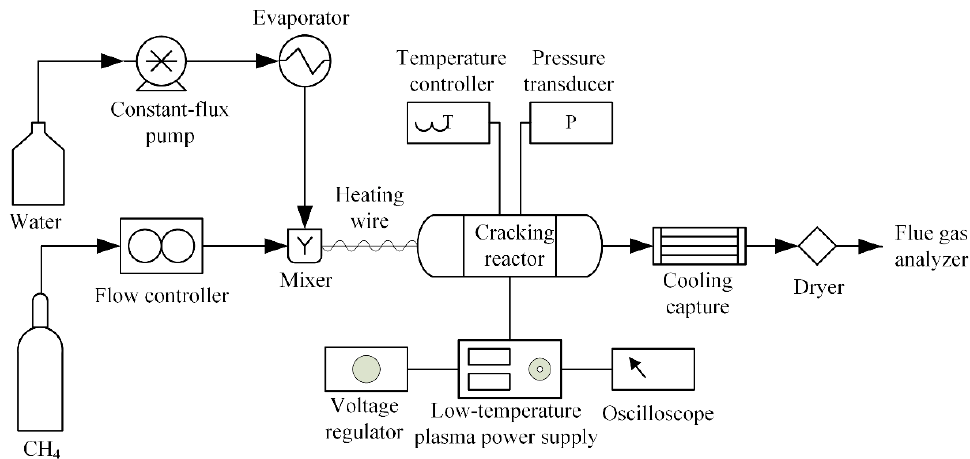
Figure 7. Arrangement diagram of a low-temperature plasma catalyzed CH 4 -steam reforming reaction experiment.